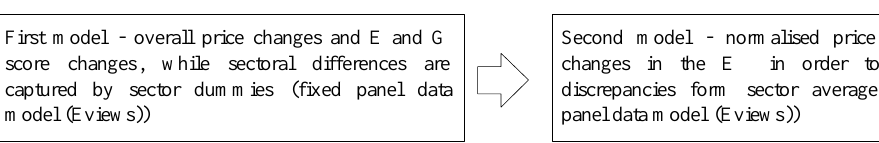
Figure 1. Process of the methodology (by